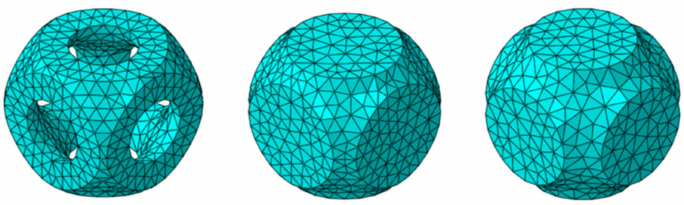
Figure 5. FE models of open, thin- and thick-walled closed unit